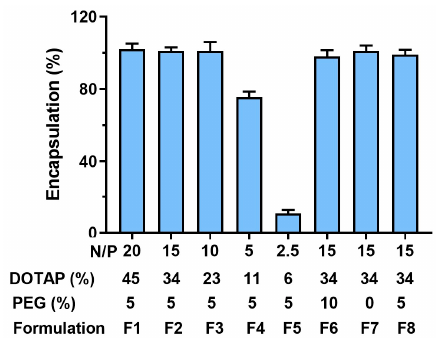
Figure 2. Loading efficiency of liposomal ADU-S100 formulations with varying levels of DOTAP and PEGylation. Data are shown as the mean ± SD ( n ≥ 3) and are representative of three independent formulation preparations.